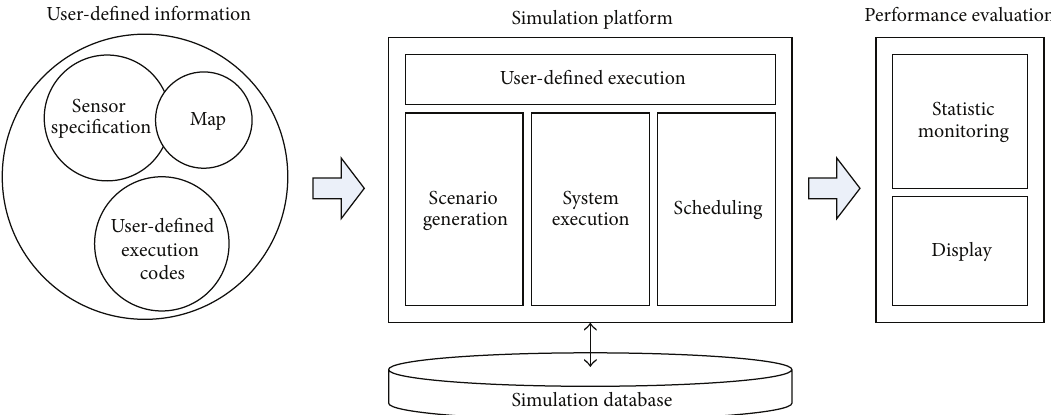
Figure 2: Simulation overview and system platform